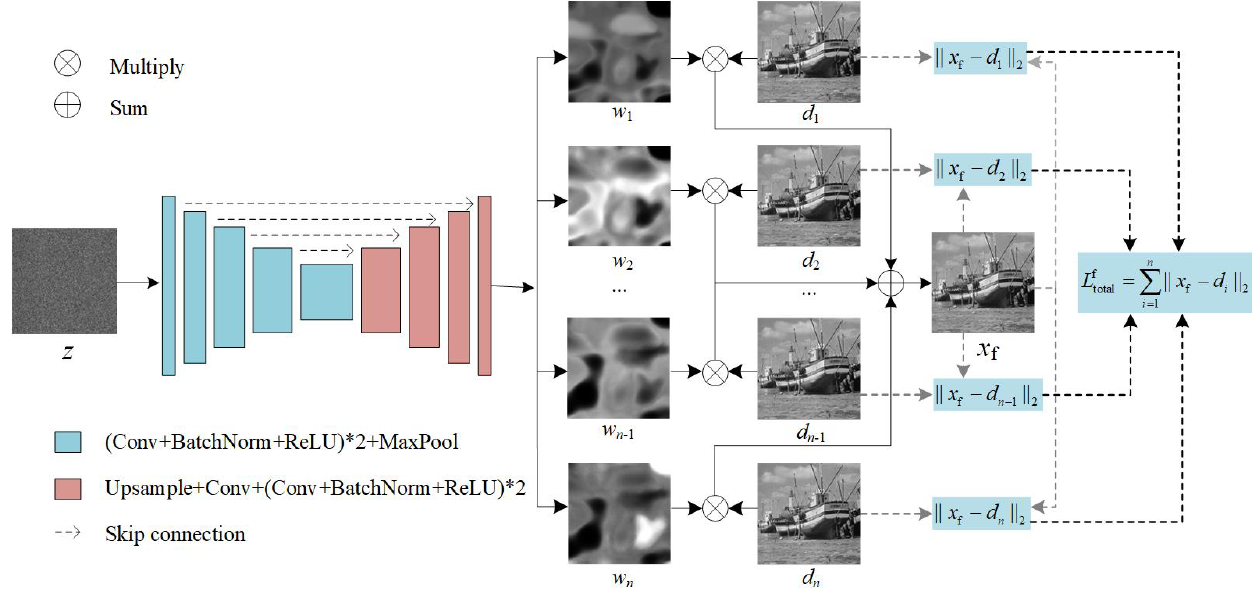
Figure 7. Unsupervised intermediate denoising images fusion